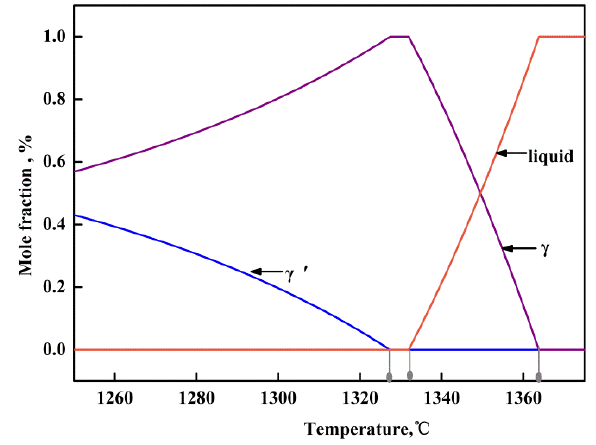
Figure 7. Calculated phase diagram based on the constituents of the intragranular γ′ phase.